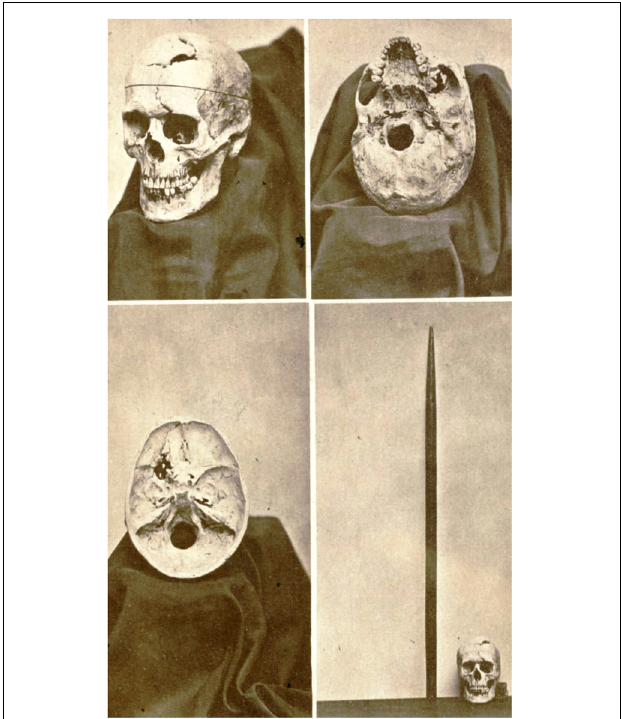
FIGURE 4 | The skull of Phineas Gage and the iron bar that pierced his skull in the accident on 13 September 1848, as shown in a catalogue of the Warren Anatomical Museum, Harvard Medical School (Jackson,